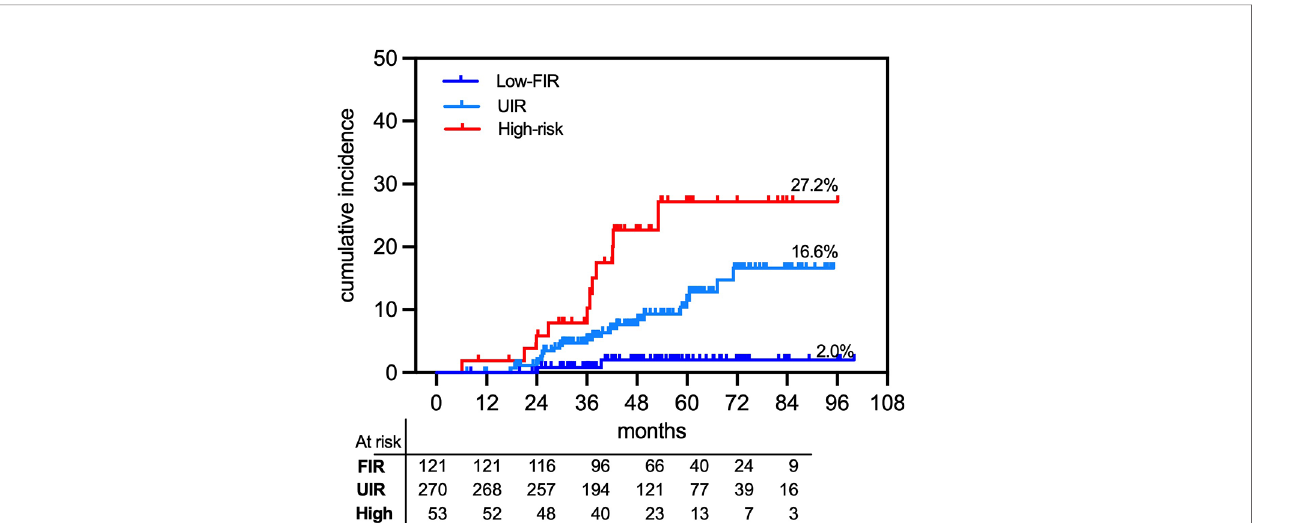
FIGURE 2 | Actuarial prostate-speci fi c antigen (PSA) relapse in 444 organ-con fi ned primary prostate cancer treated with rectal distension-mediated 5 × 9 Gy SABR. Patient groups are de fi ned as combined low-risk and favorable intermediate-risk (FIR), unfavorable intermediate-risk (UIR), and high-risk (High) patients.